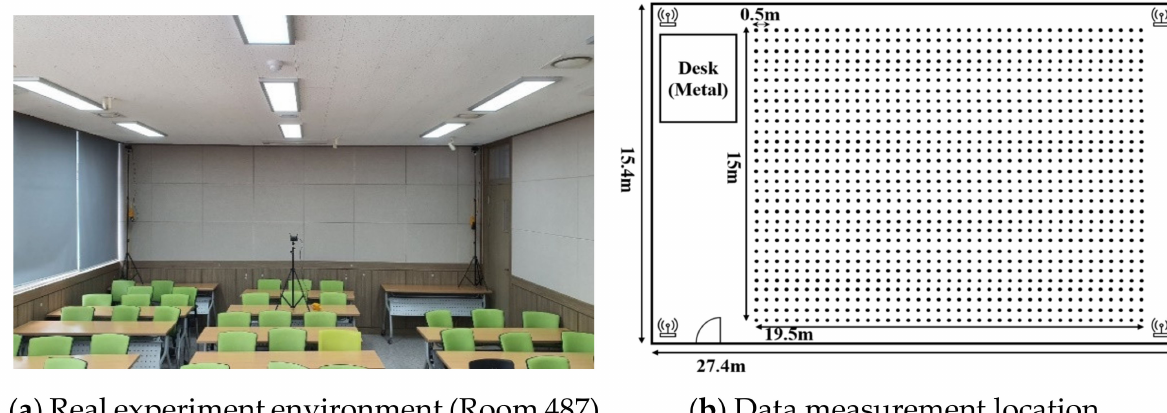
Figure 6. Experimental environment of proposed